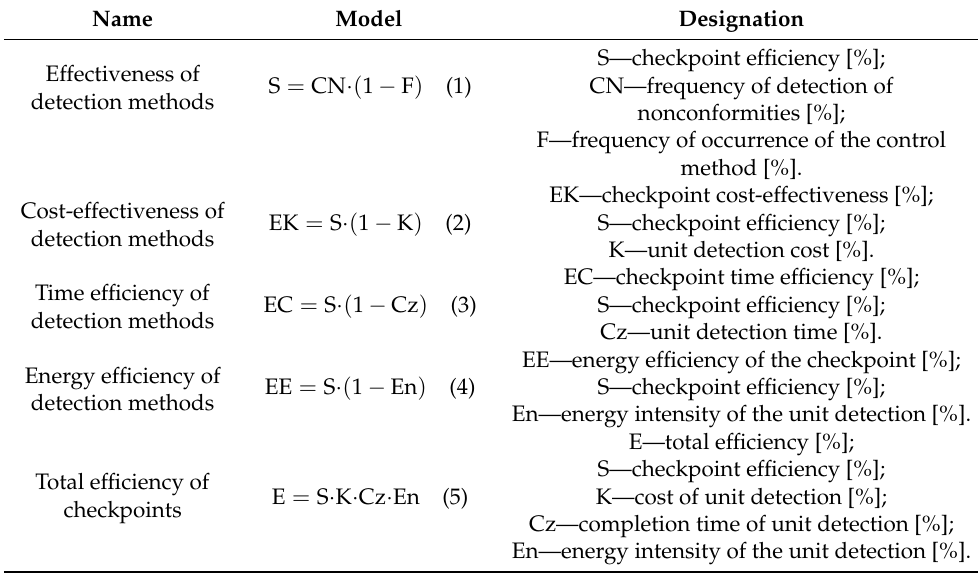
Table 2. Formulae needed to develop methods’ validity